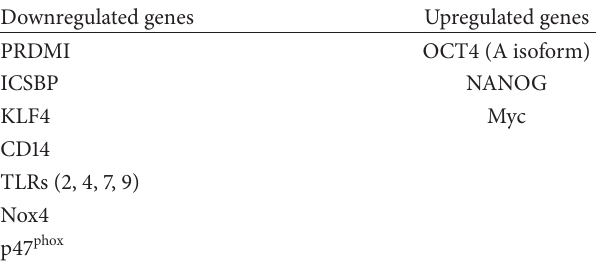
Table 1: List of specific genes and their mode of regulation during the monocyte → PCMO